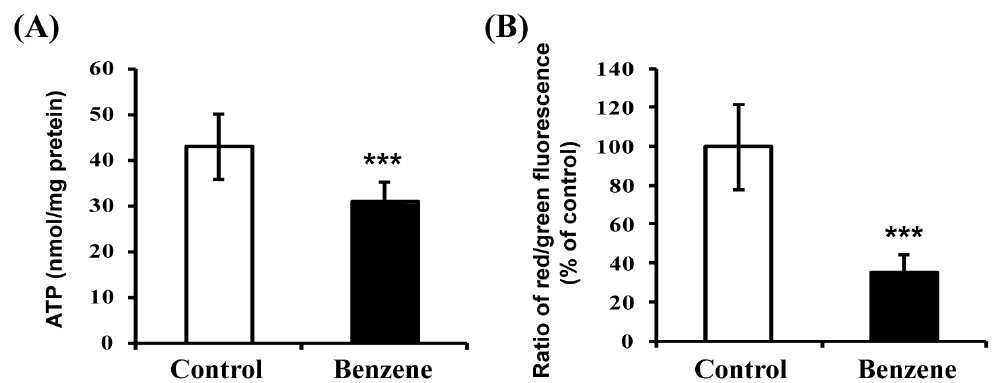
Figure 5. Benzene causes mitochondrial dysfunction in mouse BM cells. The ATP level ( A ) and mitochondrial membrane potential ( B ) were determined. Values are mean ± SD; *** p < 0.001, compared with control group.